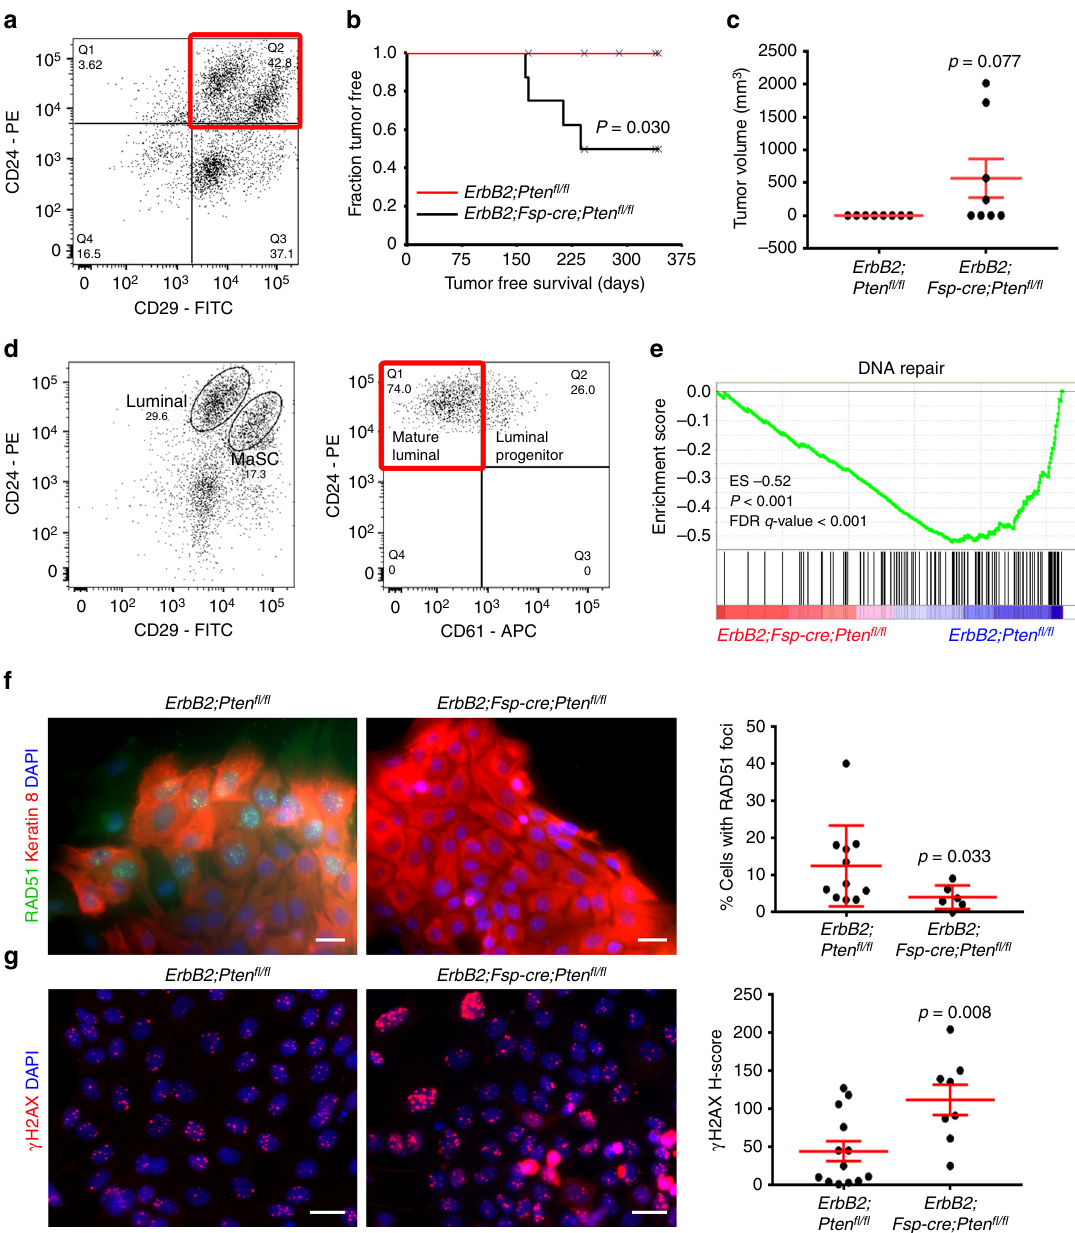
Fig. 1 Loss of stromal PTEN decreases the DNA repair response in associated mammary epithelium. a Representative FACS plot de fi ning CD24 + CD29 + mammary epithelium ( ErbB2;Fsp-cre;Pten fl / fl ). b Tumor-free survival of wild-type FVB/N mice injected orthotopically with ErbB2;Fsp-cre;Pten fl / fl versus control ErbB2;Pten fl / fl epithelium ( n = 8/genotype). P value determined by Log-rank (Cox-Mantel). c Tumor volume (mean ± s.e.m.) at time of harvest after orthotopic injection of ErbB2;Fsp-cre;Pten fl / fl ( n = 8) versus control ErbB2;Pten fl / fl ( n = 7) epithelium. P value determined by Fisher ’ s exact. d Representative FACS plot de fi ning ErbB2;Pten fl / fl mammary epithelial subpopulations segregated by CD29 and CD24 (left: luminal and mammary stem cell (MaSC)) and CD61 (right: mature luminal and luminal progenitor). e Gene set enrichment analysis (GSEA) for DNA repair genes in ErbB2;Fsp-cre;Pten fl / fl versus control ErbB2;Pten fl / fl mature luminal epithelium. f Representative RAD51/keratin 8 dual immuno fl uorescence and quanti fi cation (mean ± s.e.m.) of epithelial